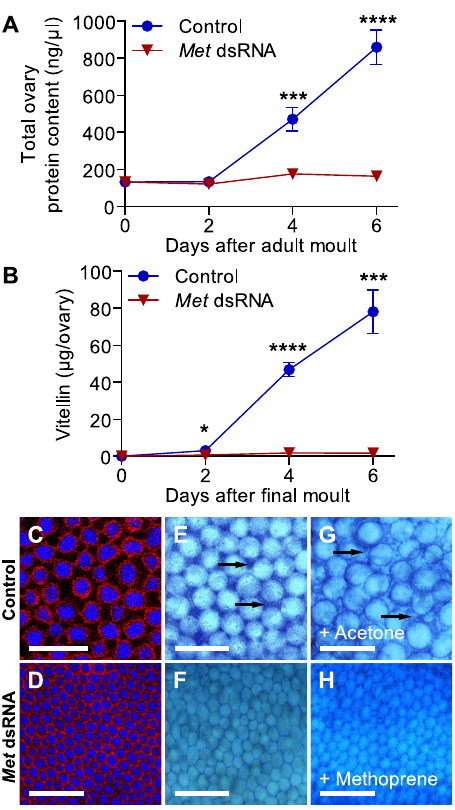
Figure 5. Patency is abolished in DippuMet dsRNA-treated animals. Total soluble protein (A) and vitellin (B) extracted from single ovary of control (blue circles) and DippuMet dsRNA (red triangles) animals during the first gonadotropic cycle. Vertical bars indicate SEM, N=5–7. C – H , morphology of the basal oocyte follicular epithelium from 4-day-old control and DippuMet dsRNA ovaries. Follicle cells were fluorescence stained (C–D) for cell nuclei (DAPI, blue), and F-actin (phalloidin-TRITC, red), or stained with Evans blue (E-F) for intercellular spaces (arrows). G – H , Evans blue staining of control and DippuMet dsRNA ovaries dissected from attempted rescue animals with 100 m g topical methoprene. Scale bars indicate 50 m m.